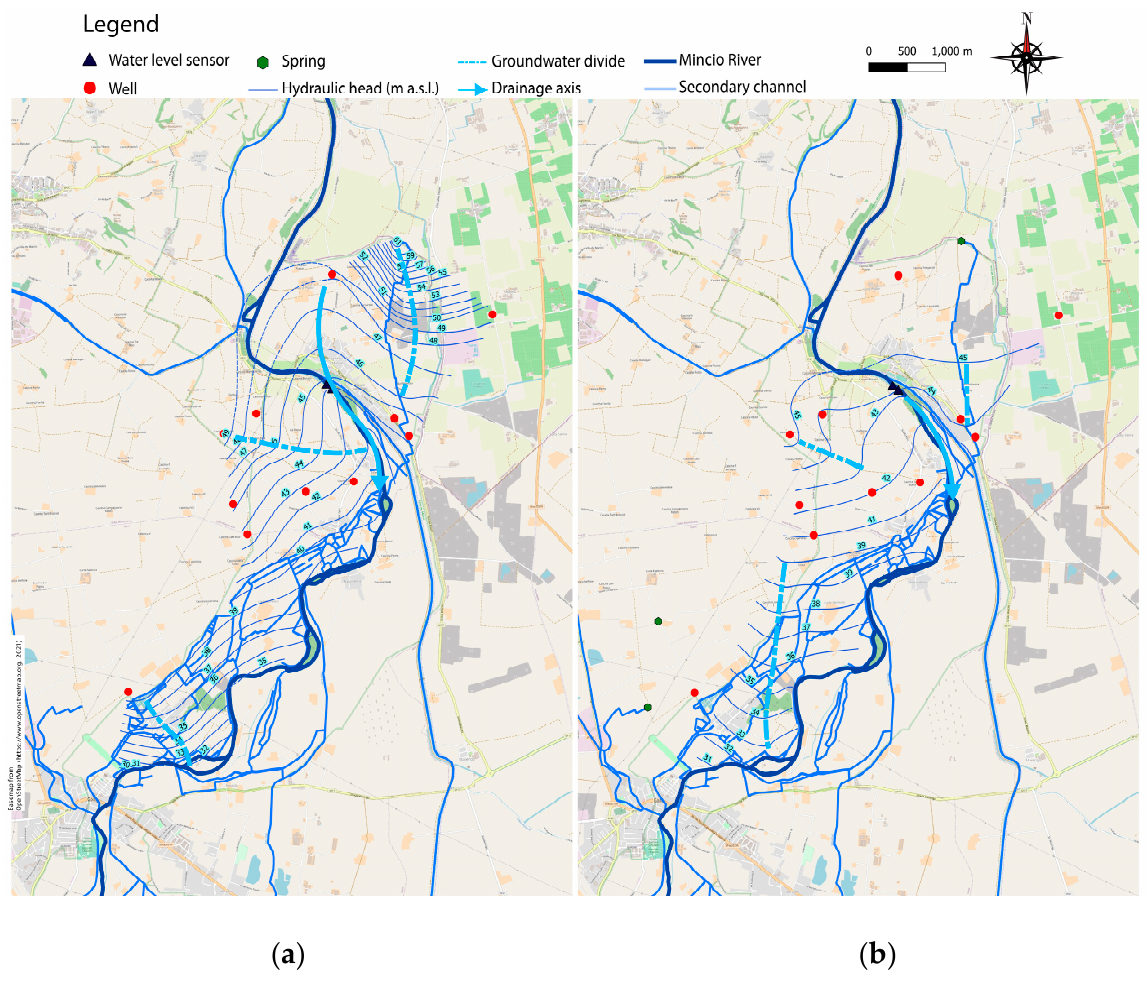
Figure 2. Potentiometric maps. ( a ) Potentiometric map of August 2020; ( b ) Potentiometric map of March 2021. Basemap from OpenStreetMap (https://www.openstreetmap.org, accessed on 6 December 2021).